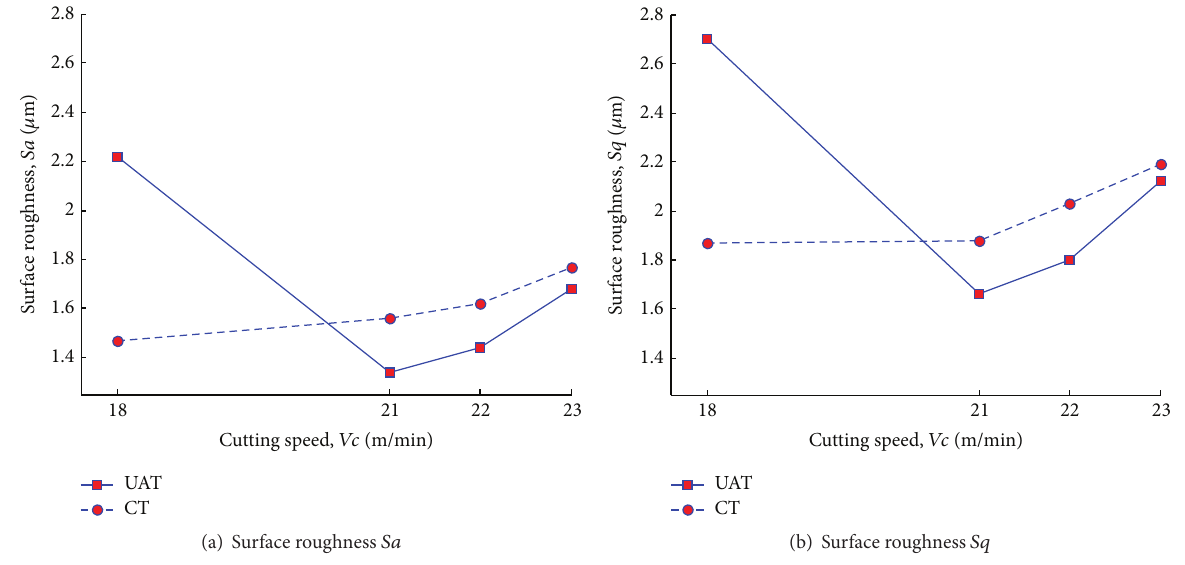
Figure 20: Relation curve of surface roughness changed with cutting